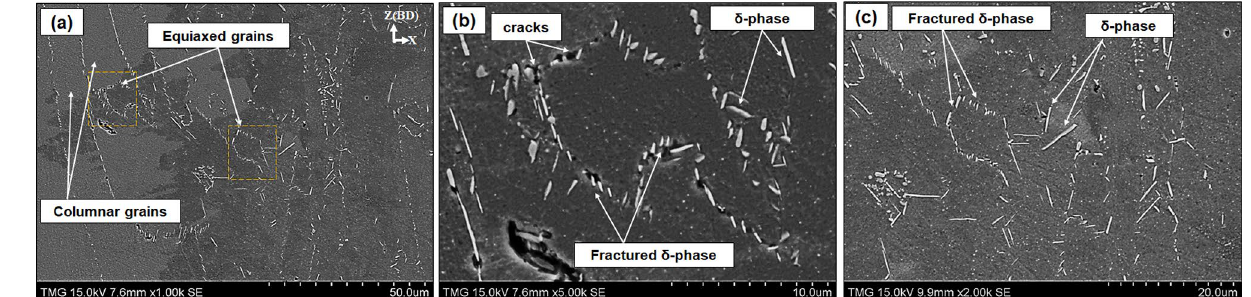
Figure 9. SEM micrograph displaying the longitudinal plane of the fracture surface of the HSA2 sample: ( a ) overall view of the fracture surface; ( b , c ) magnified view of the fracture surface as indicated in the overall view ( a